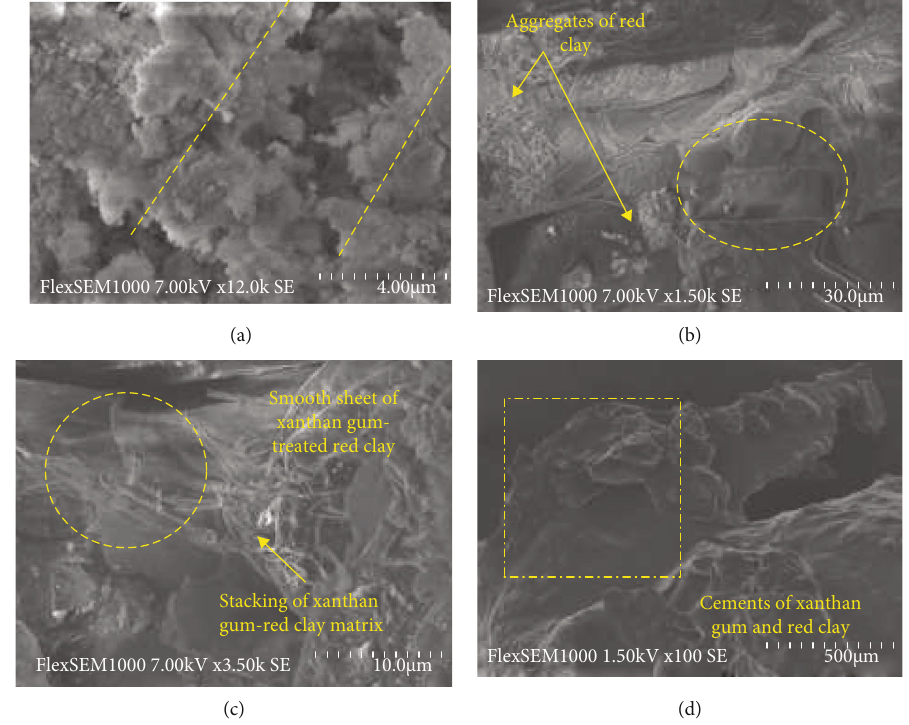
Figure 16: SEM images of (a) red clay, (b) 1.0% treated soil, (c) 1.5% treated soil, and (d) 2.0% treated